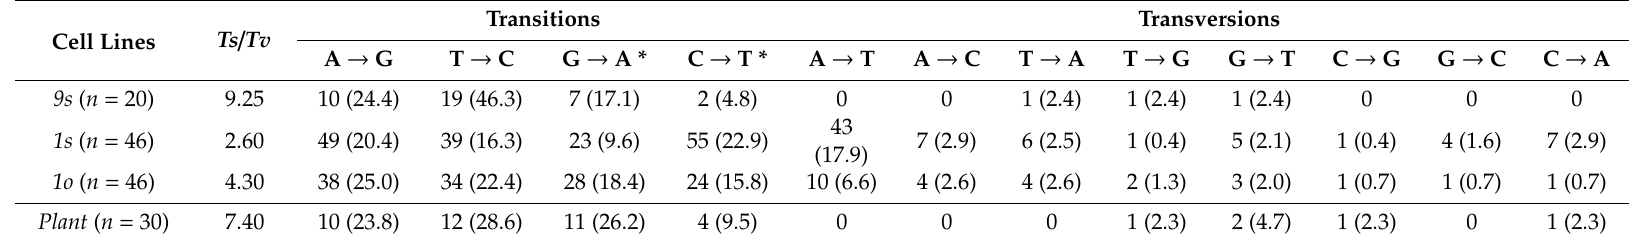
Table 2. Nucleotide substitutions in the 18S rDNA clones of the Panax ginseng cell